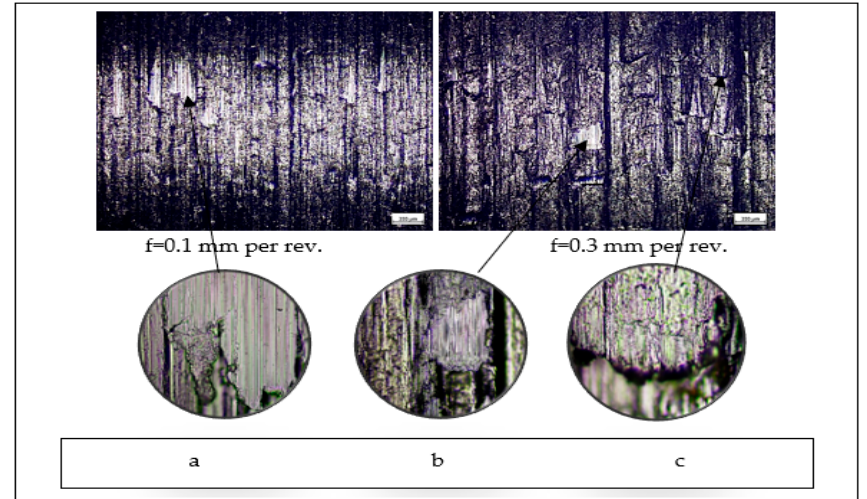
Figure 14. Examples of negative phenomena on the machined surface after turning steel C45 at a feed of f = 0.1 mm per revolution. a : f = 0.3 mm per revolution ( a : spreading of material on the machined surface, b : surface after breakage of the material element, c : crack on the machined surface).